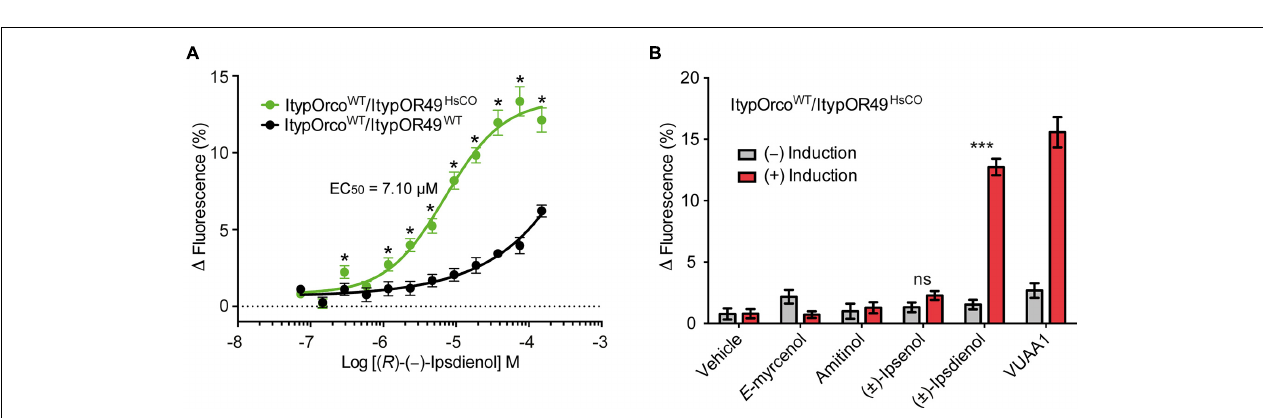
FIGURE 2 | Response to VUAA1 of cells expressing bark beetle Orco genes. (A) Cells expressing the codon optimized I. typographus Orco gene (ItypOrco HsCO ; n = 6 biological replicates; n total = 18) demonstrate increased maximal response and a somewhat lower EC 50 value as compared to cells expressing the wildtype Orco gene (ItypOrco WT ; n = 5 biological replicates [replicates 1–3 from Yuvaraj et al. (2021)]; n total = 15). Asterisks (*) indicate significantly higher responses in ItypOrco HsCO as compared to ItypOrco WT ( p = 0.002 to < 0.001). (B) Cells transfected with either the wildtype or codon optimized Orco gene from D. ponderosae (DponOrco WT and DponOrco HsCO ) failed to respond to VUAA1 ( n = 3 biological replicates, n total = 9), with similar (cid:49) fluorescence values in induced and non-induced cells (not shown in graph for clarity; see Supplementary Data 1 ). Error bars show SEM.